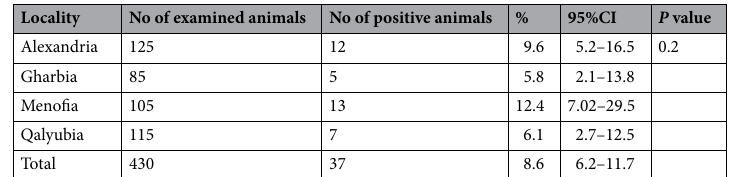
Table1. Prevalence of anti- N. caninum antibodies in sheep in different governorates. The result is non- significant at P > 0.05.